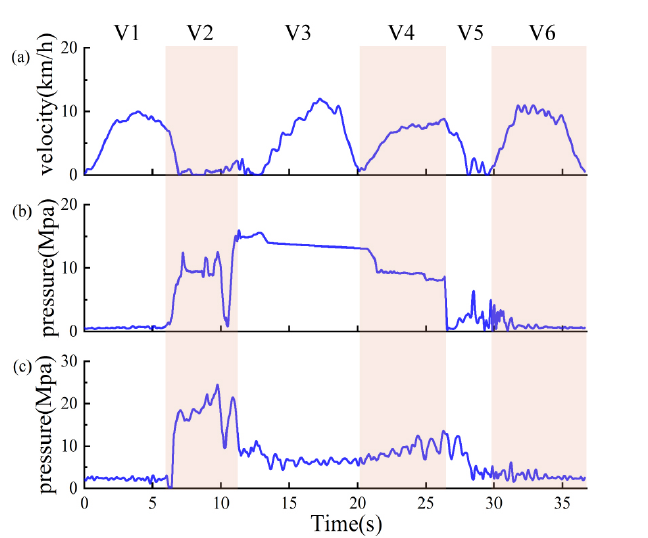
Figure 5. Schematic diagram of working condition division. ( a ) Velocity of wheel loader. ( b ) Lift cylinder pressure. ( c ) Tilt cylinder